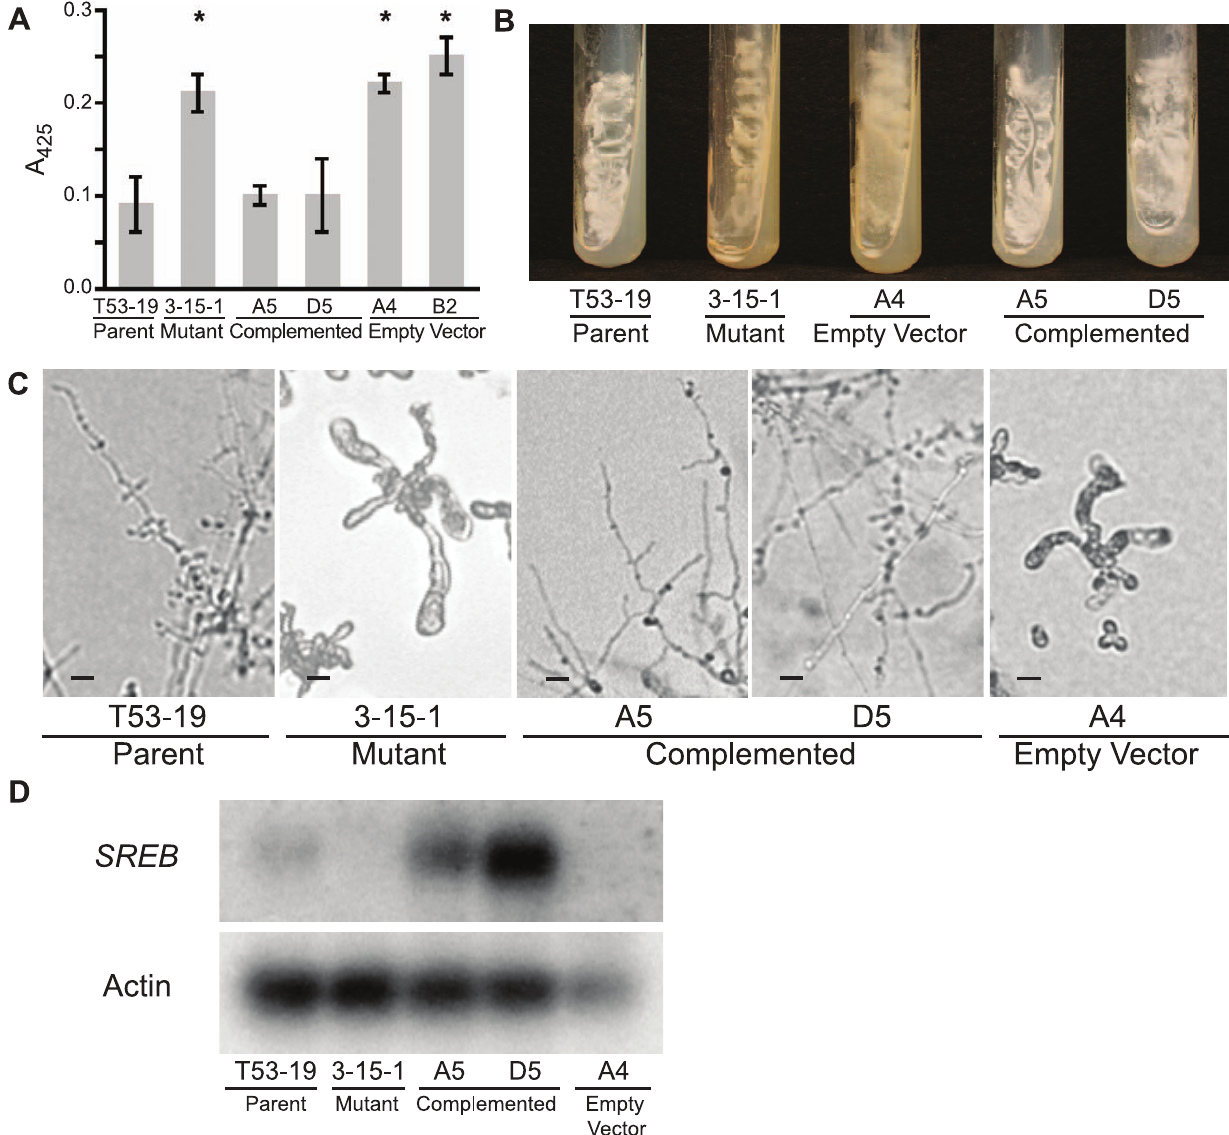
Figure 2. Complementation of insertional mutant 3-15-1. ( A ) Under iron-replete conditions (10 m M FeSO 4 ), mutant 3-15-1 and empty vector controls fail to suppress siderophore biosynthesis as demonstrated by a 2.5–3.0 fold higher absorbance at 425 nm compared to parental strain T53- 19 and complemented strains A5 and D5 (p , 0.01 as indicated by asterisk). Data from three independent experiments were analyzed. Siderophore production was measured using the ferric perchlorate assay. ( B ) Mutant 3-15-1 and empty vector control A4 were pigmented yellow and discolored the surrounding media when grown on 7H10 medium, which contains 150 m M FeSO 4 . In contrast, parental control T53-19 and complemented strains A5 and D5 were colored white and did not pigment the medium. All strains were incubated for 14 days at 37 u C. ( C ) Mutant 3-15-1 and empty vector control A4 fail to convert to mycelia upon shifting the incubation temperature from 37 u C to 22 u C. Similar to the wild-type isolate, complemented strains A5 and D5 grew as mycelia at 22 u C incubation. ( D ) Northern blot hybridization demonstrated reduction in transcript abundance in the insertional mutant when compared to the parent strain. Complemented strains A5 and D5 overexpress SREB . Transformation of 3-15-1 with an empty vector failed to restore transcript abundance in strain